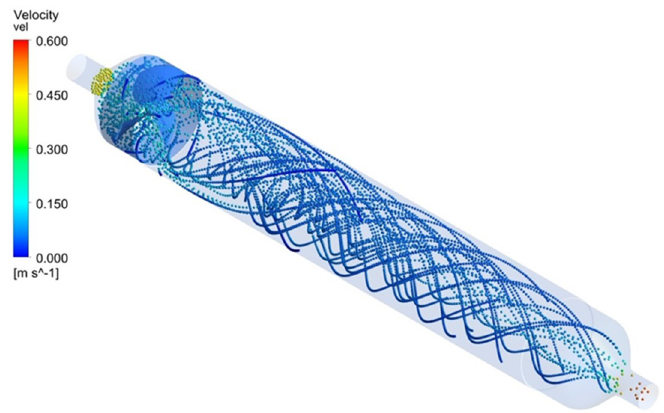
Figure 3. Computed tracks of massless particles released at the inlet to the UV system. The strong swirling motion responsible for enhanced mixing and wall cleansing is evident.